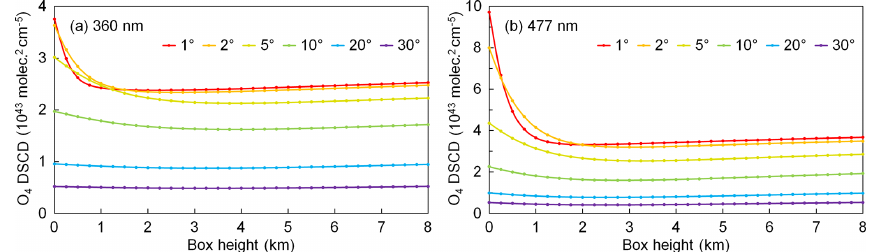
Figure B4. Simulated O 4 DSCDs at (a) 360nm and (b) 477nm for box-shape profiles with the same surface aerosol extinction coefficient of 0.04km − 1 and different box heights from 0 to 8km. The other simulation parameters followed the settings listed in Table B1.